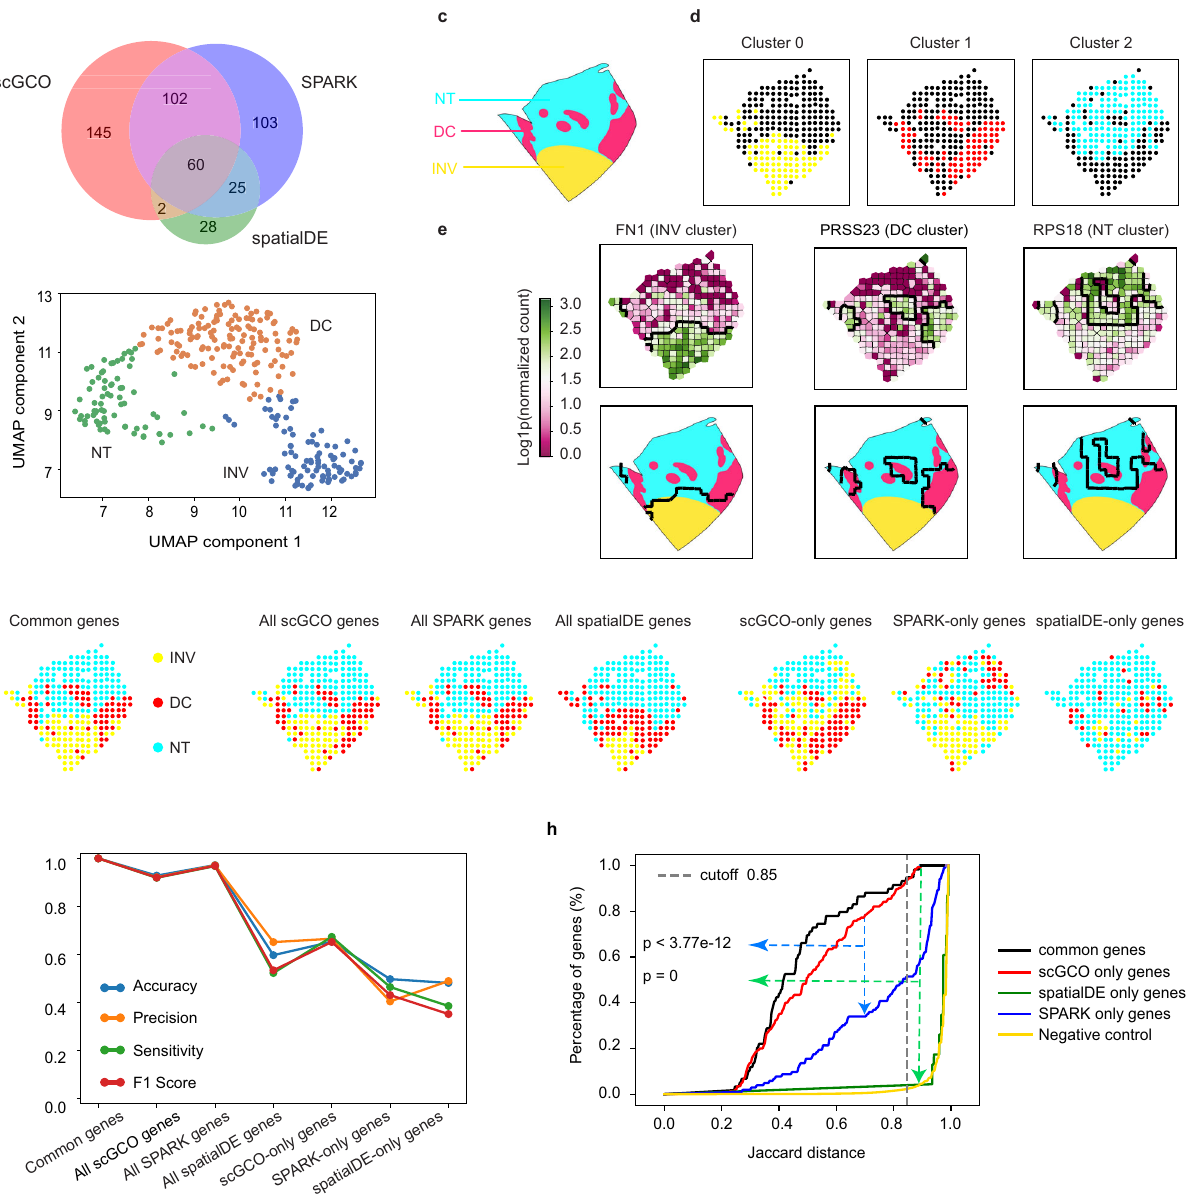
Fig. 4 | Analyses of SV gene identi fi cation algorithms using breast cancer biopsies data. a Venn diagram showing the gene set relationship among SV genesidenti fi ed by scGCO, spatialDEand SPARK inlayer2of breast cancer data. b UMAP for SV genes identi fi ed by scGCO in layer 2. c Annotated breast cancer tissue architecture showing the three known domains for layers 2. INV: Invasive Ductal Cancer; DC: Ductal Cancer; NT: Normal Tissue. d Tissue domains reconstructed with each cluster of genes identi fi ed by scGCO for layer 2. e RepresentativeVoronoidiagramsshowinggraphcutsresults(toppanels),and tissue structure overlays (lower panels) for genes in ( b ). One example was shown for each cluster. Thicker black lines represent graph cuts boundaries. f Reconstructed tissue architectures for layer 2 using SV genes jointly identi fi ed by all three methods ( fi rst panel), with all SV genes identi fi ed by scGCO (second panel), with all SV genes identi fi ed by SPARK (third panel), with all SV genes identi fi ed by spatialDE (fourth panel), with SV genes uniquely identi fi ed by